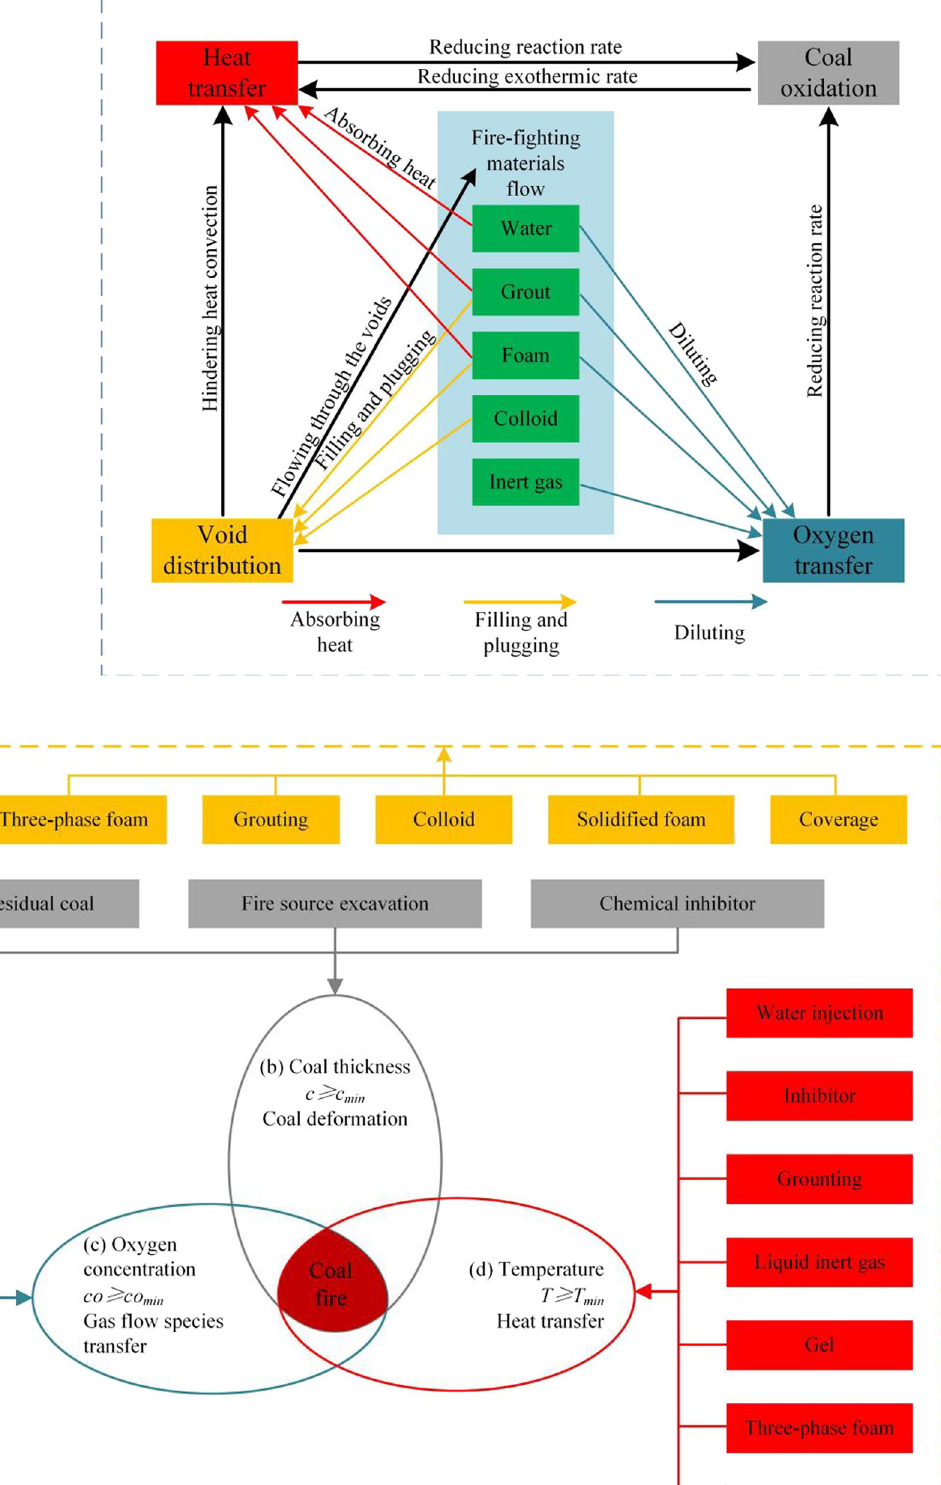
Fig. 8 Mechanism of action of fire extinguishing materials (Wang et al. 2016)